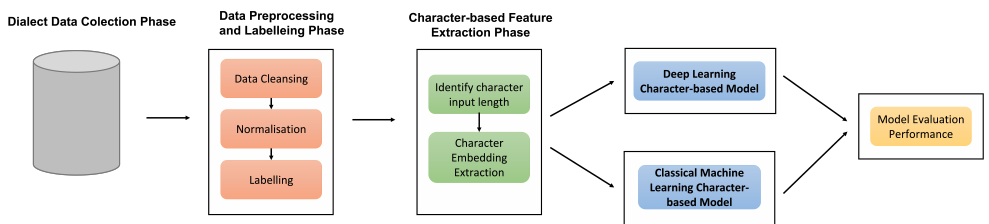
Figure 1. The adaptive ADI approach, including five main